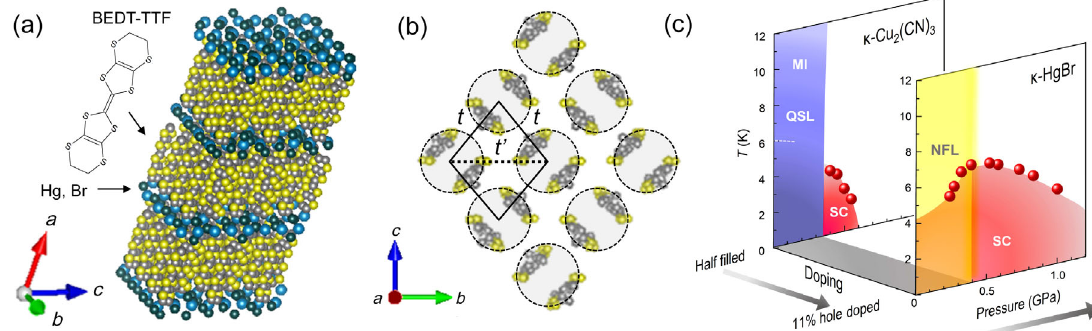
FIG. 1. Structure and phase diagram of κ - ð BEDT-TTF Þ 4 Hg 2 Br 8 . (a) Layered structure consisting of BEDT-TTF conducting layers . 89 and Hg 2 Br 8 insulating layers. BEDT-TTF denotes bis(ethylenedithio)tetrathiafulvalene. The nonstoichiometry in the Hg composition . 89 comes from the fixed incommensurability between the Hg and BEDT-TTF lattices originating from material chemistry, not from extrinsic defects. (b) In-plane structure of the conducting layers. BEDT-TTF molecules form dimers, which constitute a nearly isotropic isosceles triangular lattice with the anisotropy of transfer integrals t 0 =t close to unity. (c) Pressure-temperature phase diagrams of κ - ð BEDT-TTF Þ κ - ð BEDT-TTF Þ ð CN Þ 4 Hg 2 . 89 Br 8 and a quantum spin liquid candidate 2 Cu 2 3 . The red area indicates the superconducting Br 8 depicts the non-Fermi-liquid region [corresponding to the yellow region in Fig. 2(c)]. phase. The blue area in κ - ð BEDT-TTF Þ 4 Hg 2 . 89 The purple area in κ - ð BEDT-TTF Þ 2 Cu 2 ð CN Þ 3 depicts the Mott-insulating spin liquid phase [42,43]. T c in κ - ð BEDT-TTF Þ 2 Cu 2 ð CN Þ 3 is Br 8 corresponds to the midpoint of the resistive transition observed in this study. taken from Ref. [42], and T c in κ - ð BEDT-TTF Þ 4 Hg 2 . 89 MI, QSL, NFL, and SC represent the Mott insulator, quantum spin liquid, non-Fermi liquid, and superconductivity, respectively. The white broken line indicates the location of the so-called 6 K anomaly observed in κ - ð BEDT-TTF Þ 2 Cu 2 ð CN Þ 3 [12,41,42], a possible indication of an instability of